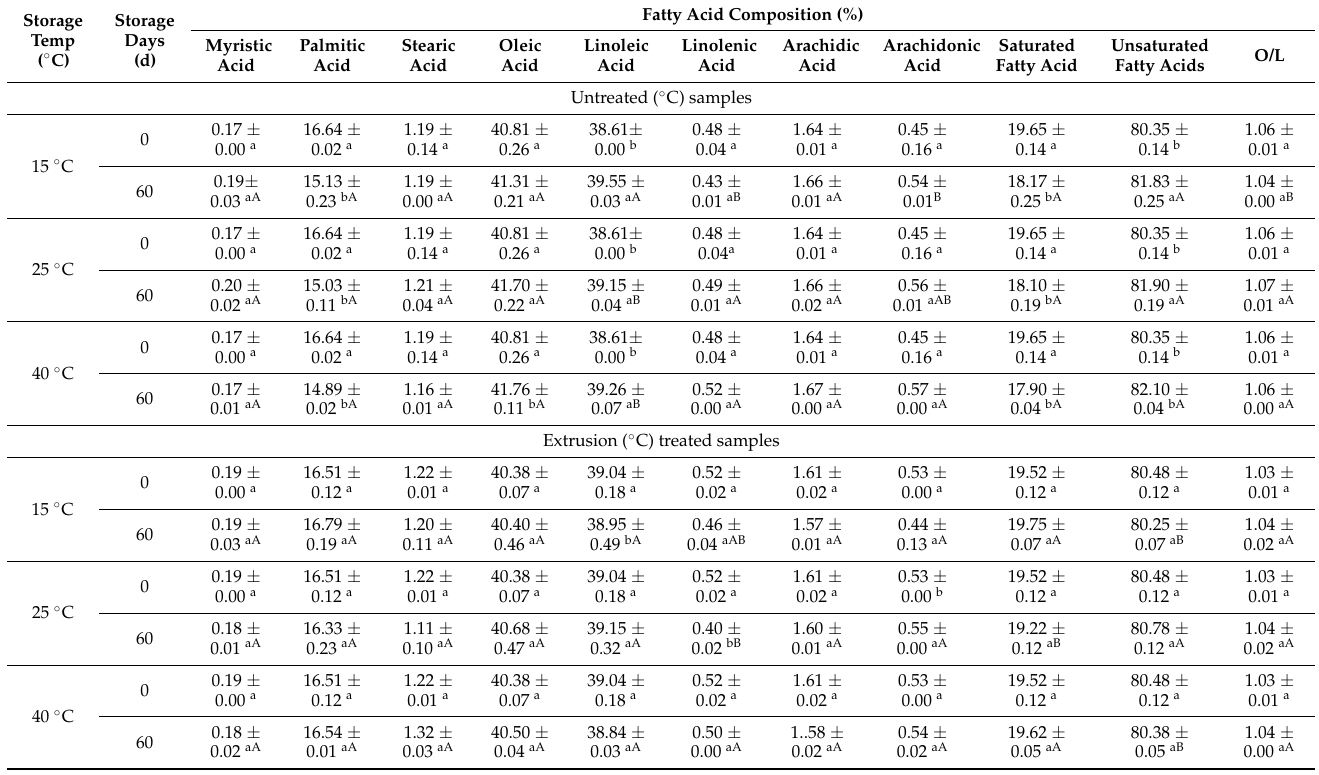
Table 3. Changes in the fatty acid composition in untreated and extruded rice bran during